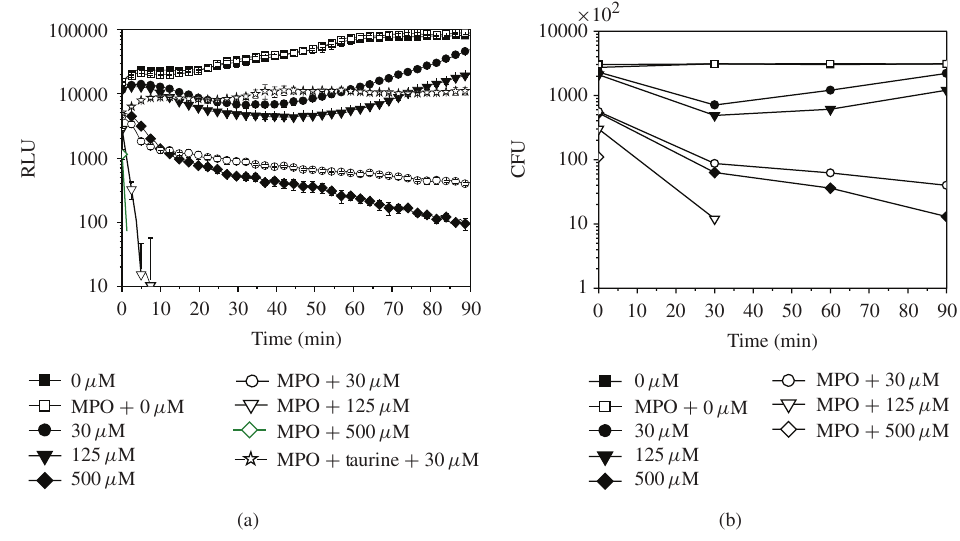
FIGURE 1: The bioluminescence signal (a) and colony forming units (CFU)/200 µ L (b) of E. coli -lux (3 × 10 5 cells) incubated in the presence of various amounts of H 2 O 2 ( µ M) and 1 µ g/well MPO in phosphate buffer at 37 ◦ C. ( (cid:2) ) 0 µ M, ( • ) 30 µ M, ( (cid:3) ) 125 µ M, ( (cid:4) ) 500 µ M, ( (cid:5) ) MPO + 0 µ M, ( (cid:3) ) MPO + 30 µ M, ( ∇ ) MPO + 125 µ M, ( ♦ ) MPO + 500 µ M, and ( (cid:5) ) MPO + 50 mM of taurine + 30 µ M. Relative luminescence unit (RLU) values are shown as the mean ± SD of measurements from three parallel wells.